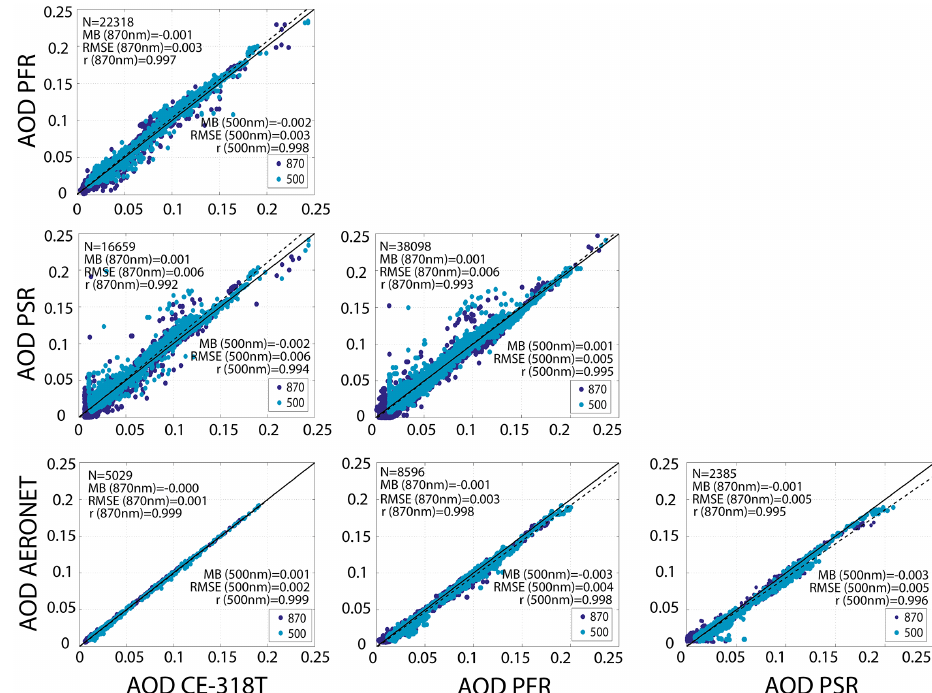
Figure 5. Scatter plots of AOD at 870nm (blue) and 500nm (cyan) using four different and independent measurements (CE318-T, CE318- AERONET, PFR and PSR) during March, April, May and June 2014 at IZO. In each figure, the dotted line represents the linear regression line, and the solid line is the diagonal.